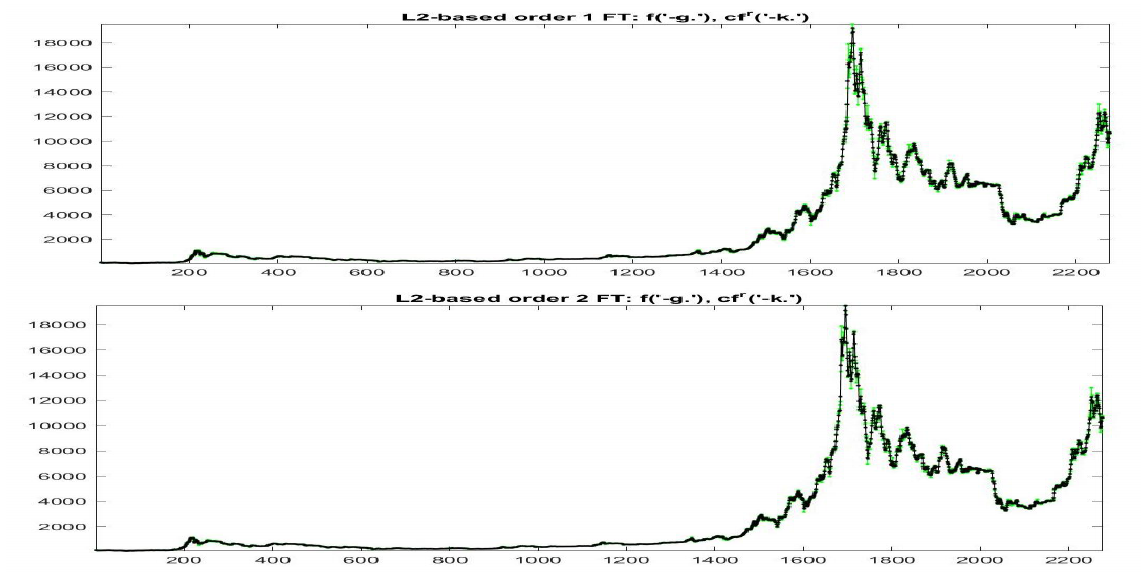
( t ) ( top : q = 1, bottom : q = 2) for Bitcoin j c , ( P a , A , r )